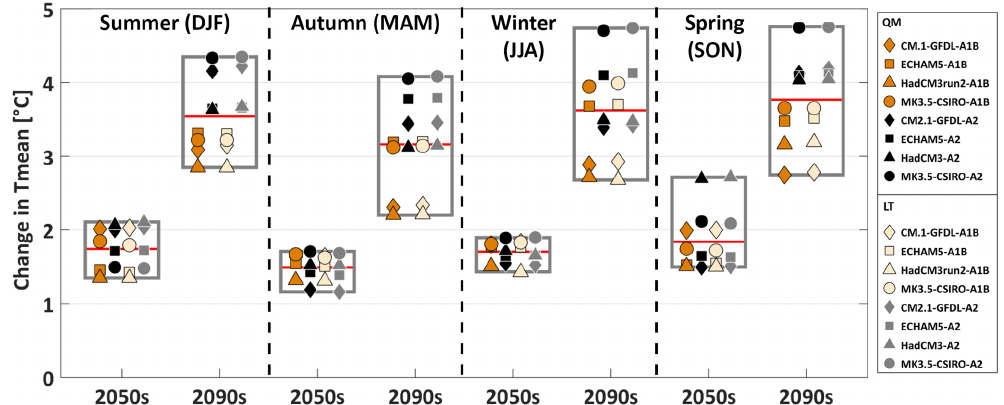
Figure 7. The uncertainty range of the T mean signal is shown for the entire ensemble and the four seasons. For each box the uncertainty range is broken down into the two emission scenarios and the two bias-correction methods. The red line represents the median of all 16 members within a box.